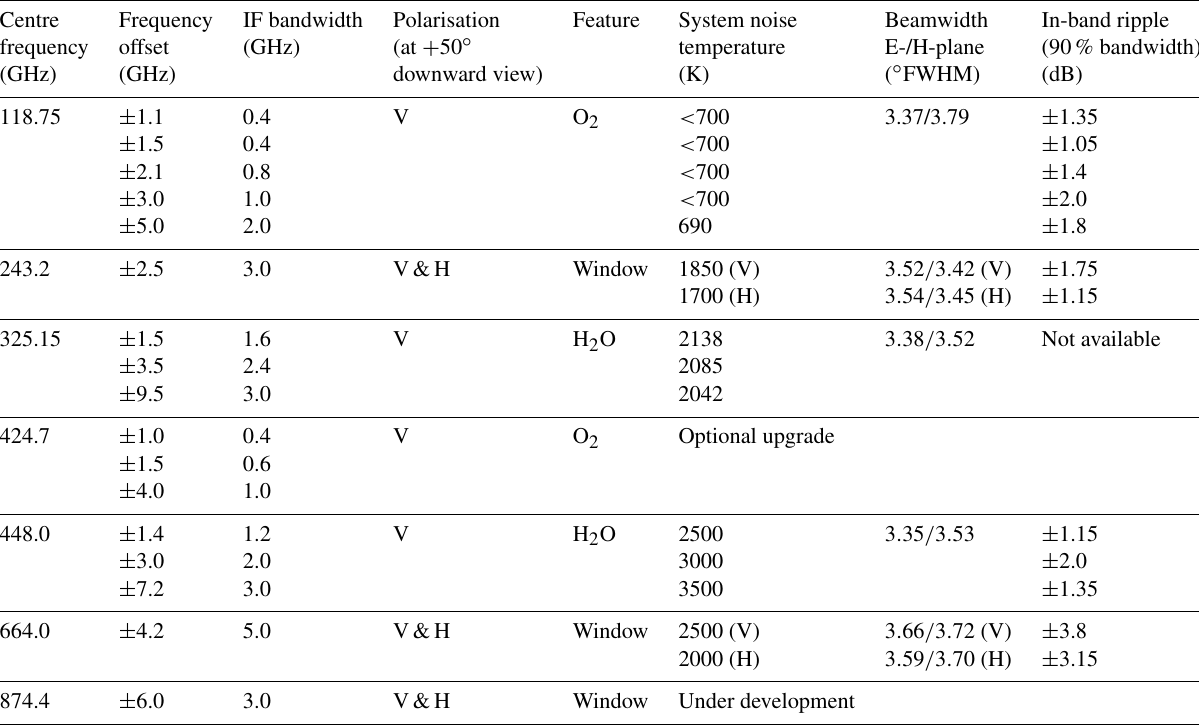
Table 1. ISMAR channel definitions (including planned upgrades).